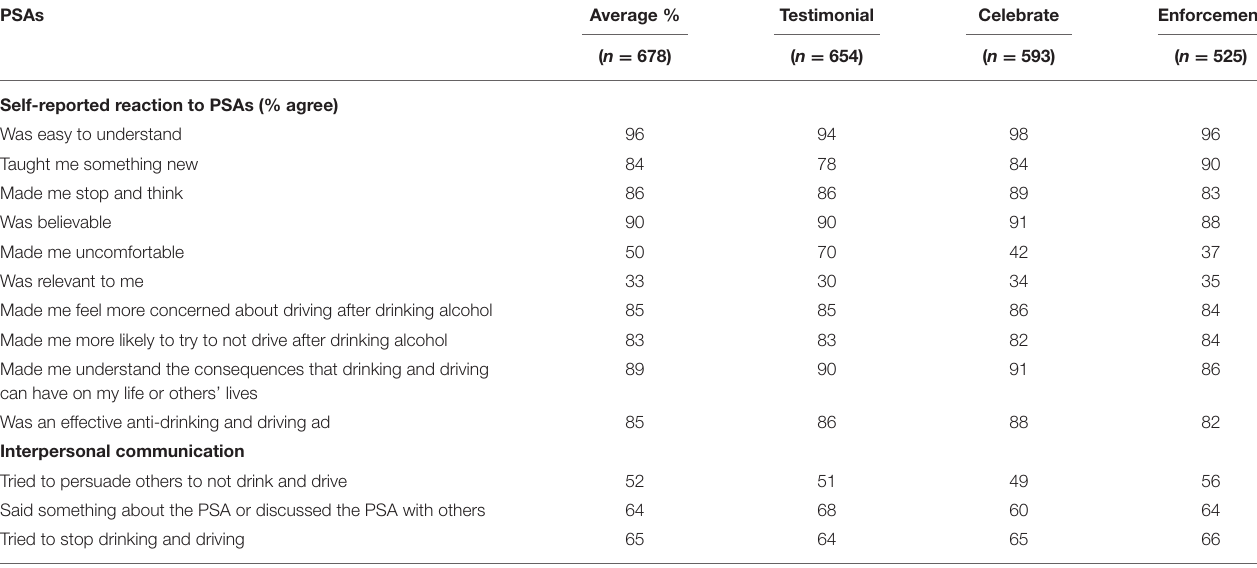
TABLE 3 | Appraisal of campaign messages and actions taken as a result of campaign awareness in post-campaign period by PSA type. PSAs Average % Testimonial Celebrate